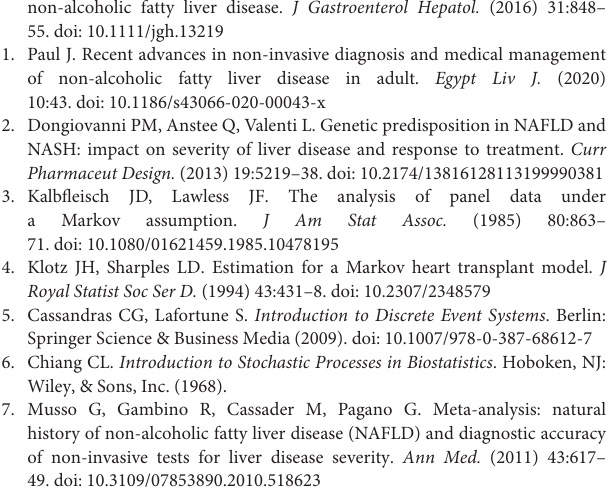
Supplementary Data-sheet 3 | Supplementary material for the expanded model. Supplementary Data-sheet 4 | MATLAB code, Appendix A (rate) and Appendix B